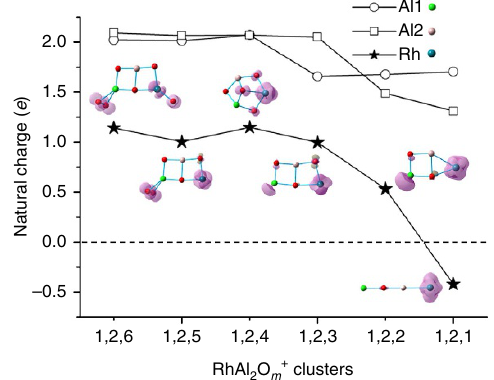
Figure 6 | Natural charge. Density functional theory (DFT)-calculated natural charges ( e ) on the Rh atom and Al atoms in RhAl 2 O 1–6 þ . The spin density distributions on individual atoms are shown in the purple